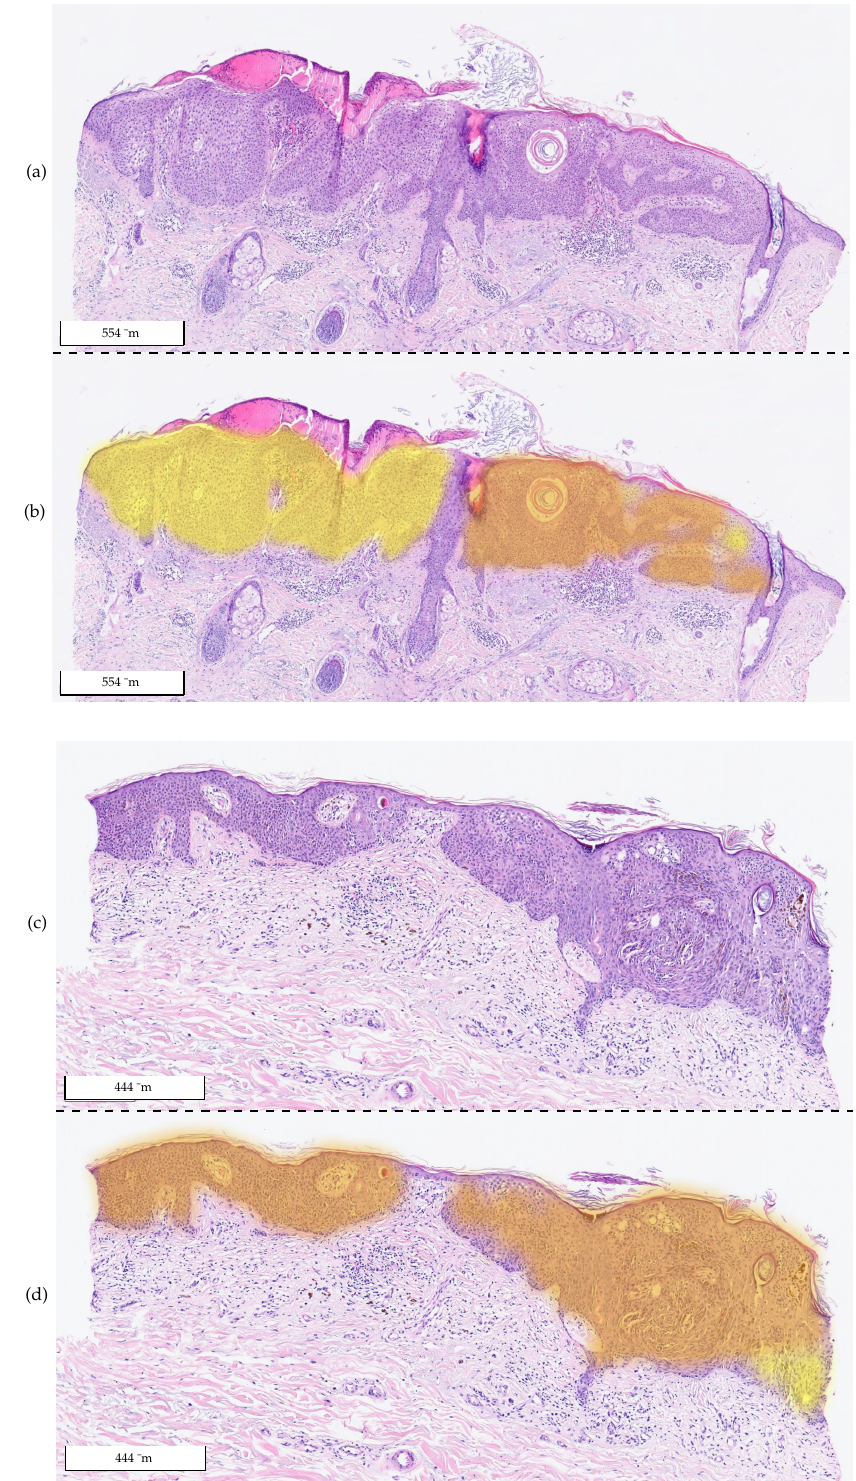
Figure 15. Exemplary tissue sections of two irritated SKs from Center 0 ( a , c ) and the same tissue sections with their corresponding 2 overlays ( b , d ): yellow (BD) and orange (SK). The probability value between 0 and 1 is used to set the transparency. The relative area for the diagnosis of BD in the first sample ( a , b ) is ( r ): 67.7% > 20%, so it was classified as BD, which was incorrect. In the second sample ( c , d ), most of the visible color was orange (SK), which was the correct diagnosis. There was a small area (lower right corner) that was identified as BD. The relative area for the diagnosis of BD was ( r ): 5.7% < 20%. Therefore, the section was classified as SK, which was